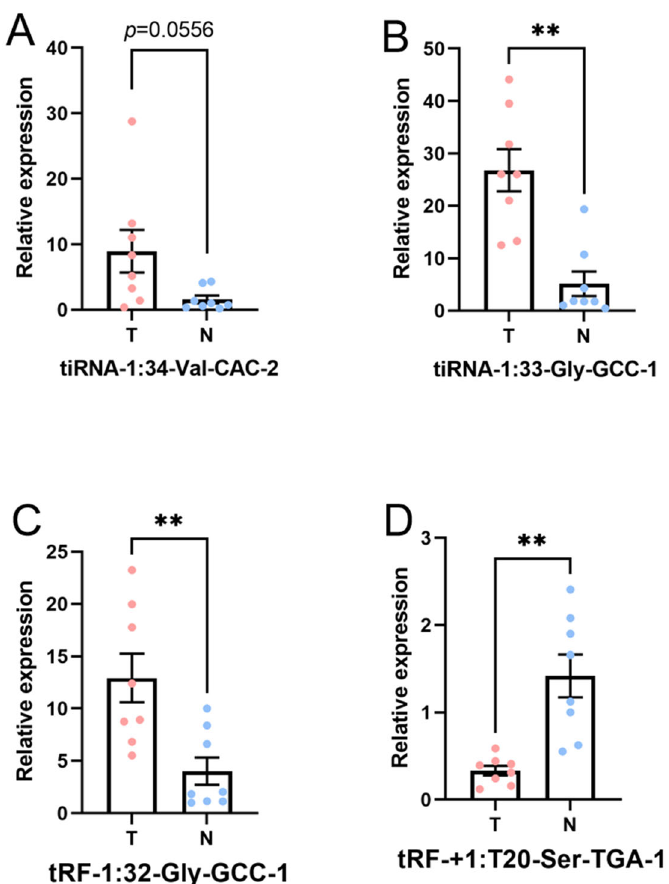
Figure 7. Expression level of the candidate tsRNAs (T, tumor group. N, paracancer group). The data were normalized using the mean ± SEM. ( A ) tiRNA-1:34-Val-CAC-2 ( p -value = 0.0556), ( B ) tiRNA- 1:33-Gly-GCC-1 ( p -value < 0.01), ( C ) tRF-1:32-Gly-GCC-1 ( p -value < 0.01), and ( D ) tRF-+1:T20-Ser- TGA-1 ( p -value < 0.01). ** indicates p -value < 0.01 . Table 3. Comparison for candidate tsRNAs expression in sequencing and PCR (T vs. N; FC, fold change.).